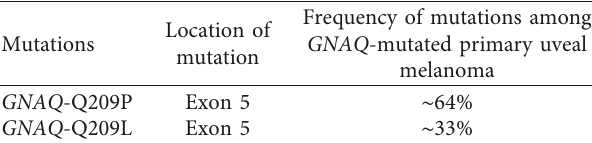
Figure 3: Liver biopsy (H&E).